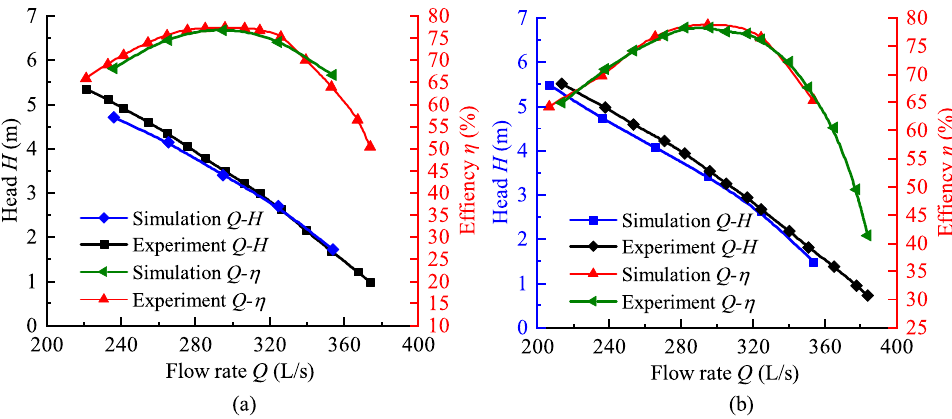
Figure 6. Comparison between numerical simulation and experimental results: ( a ) front-mounted scheme; ( b ) rear-mounted scheme.